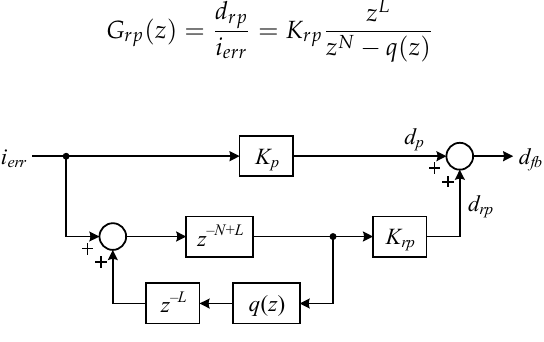
Figure 6. Current controller structure.